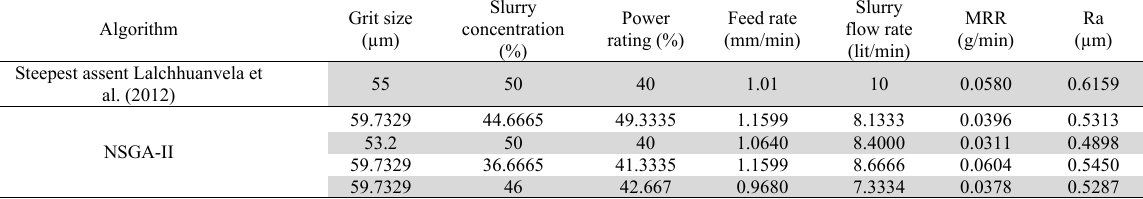
Comparison of NSGA-II results for USM